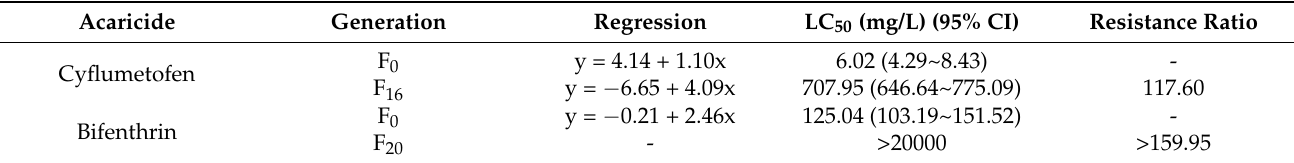
Table 1. Selection of the cyflumetofen- and bifenthrin-resistant strains of T. urticae.